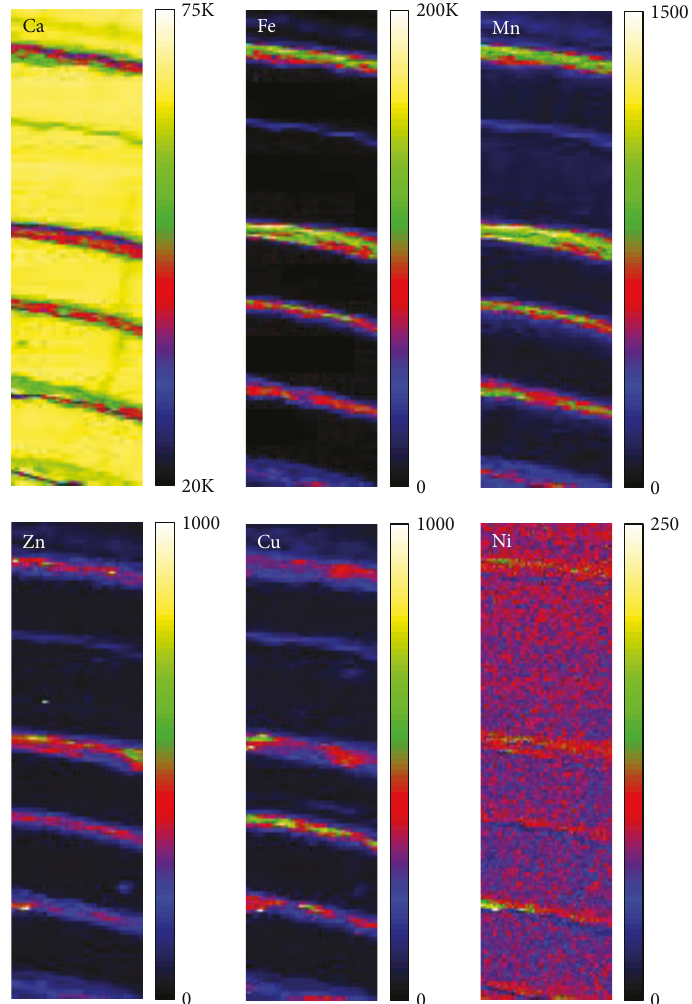
Figure 6: μ -XFM of laminated calcite forming in CPS discharge at Colour Peak Diapir. Qualitative concentrations shown as intensities in counts per second from low (black) to high (white). Intensity ranges denoted by scale bars for each element. The vertical scale of each map is 500 μ